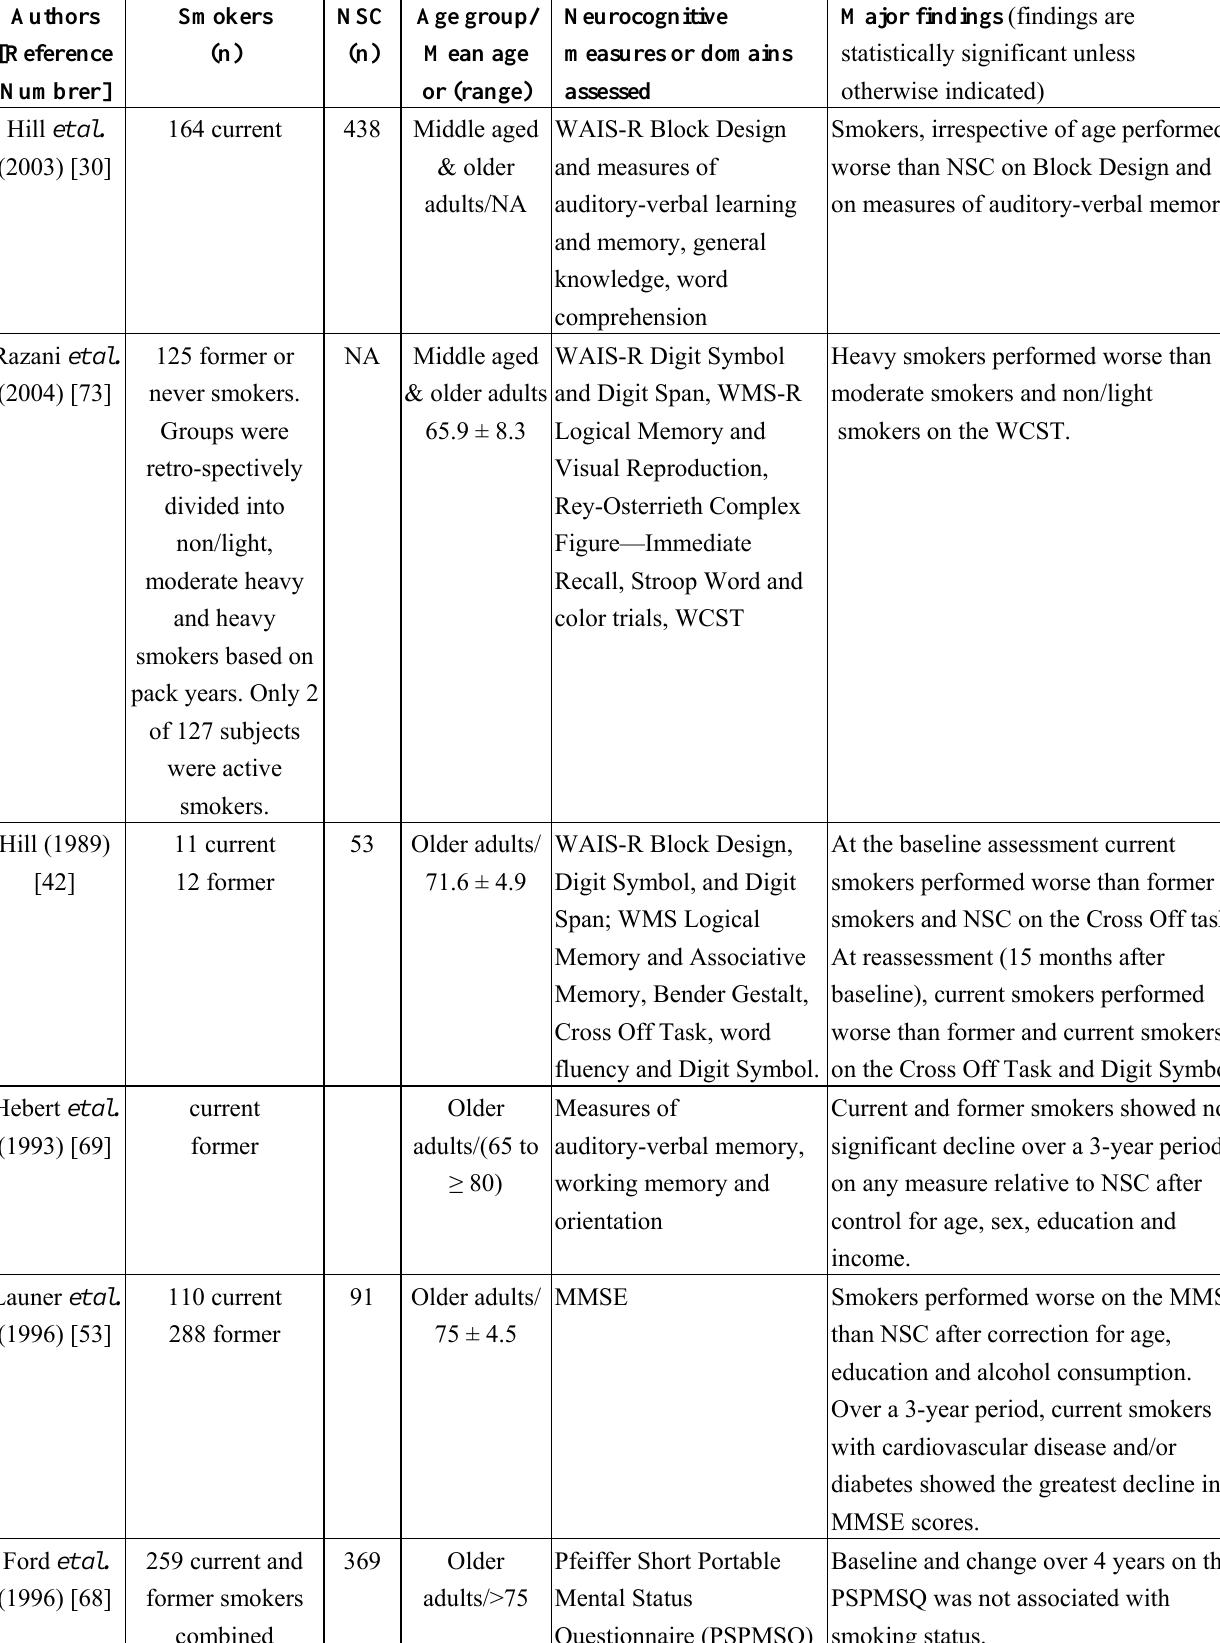
Heavy smokers performed worse than moderate smokers and non/light smokers on the